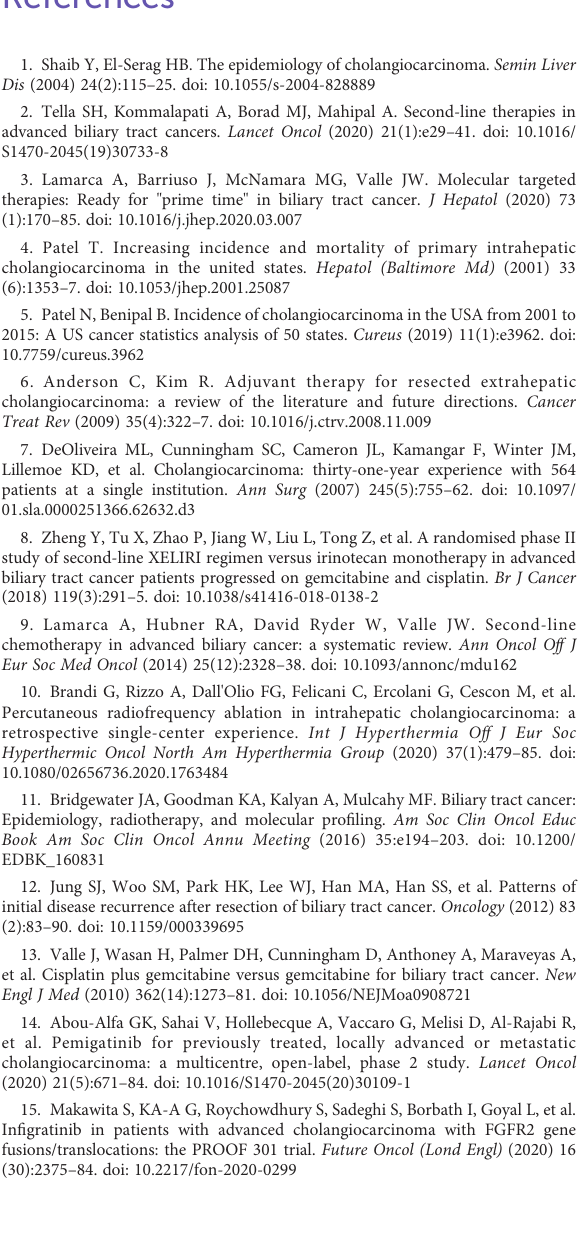
SUPPLEMENTARY FIGURE 1 Locations of TP53, KRAS, IDH1/2, NRAS, BRAF, KMT2C/D, AR, and NCOR1 alterations in the Chinese cohort. The different colors of the dots represent different alteration types. SUPPLEMENTARY FIGURE 2 Differences in somatic alterations were compared between Chinese